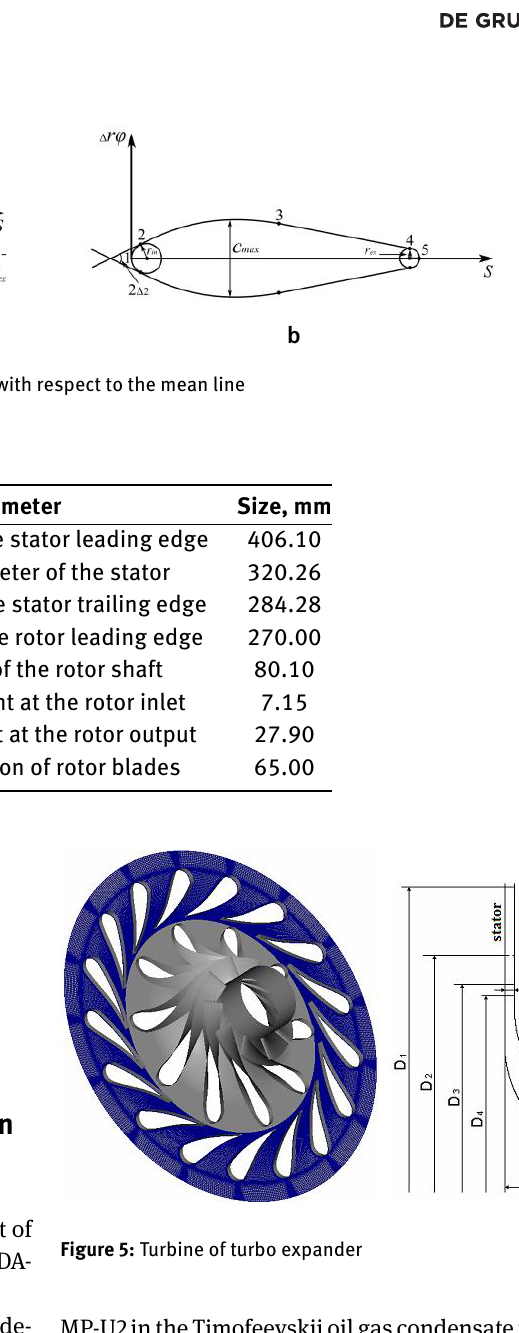
c Figure 6. Contours of static pressure and velocity vectors. Mid-blade-to-blade meridional section of the rotor: